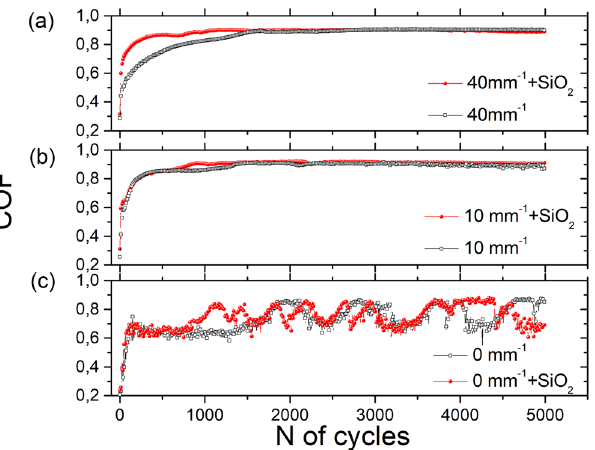
2 nanoparticles.